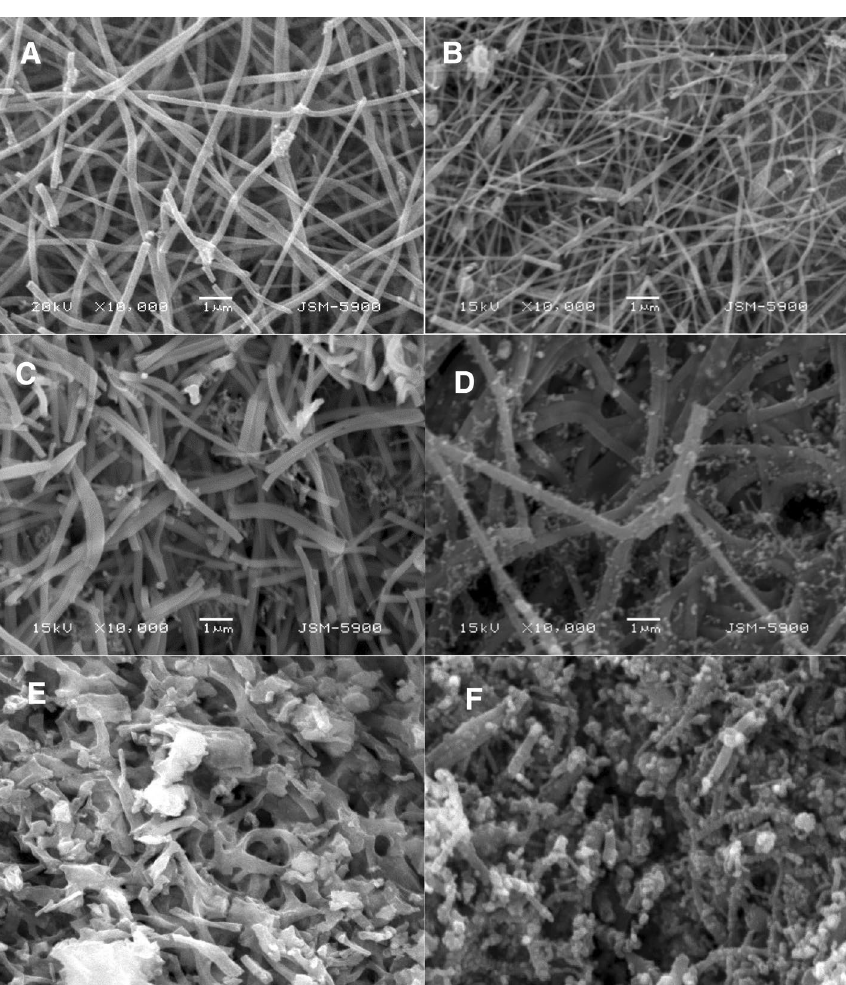
Figure 3. SEM images for the produced Mo 2 C–Ni–C composite nanofibers prepared at 850 °C calcination temperature and from original solution having 0 ( A ), 10 ( B ), 15 ( C ) and 35 ( D ) molybdenum chloride. Panels ( E,F ) display SEM images of the 35%-sample calcined at 700 and 1000 °C,